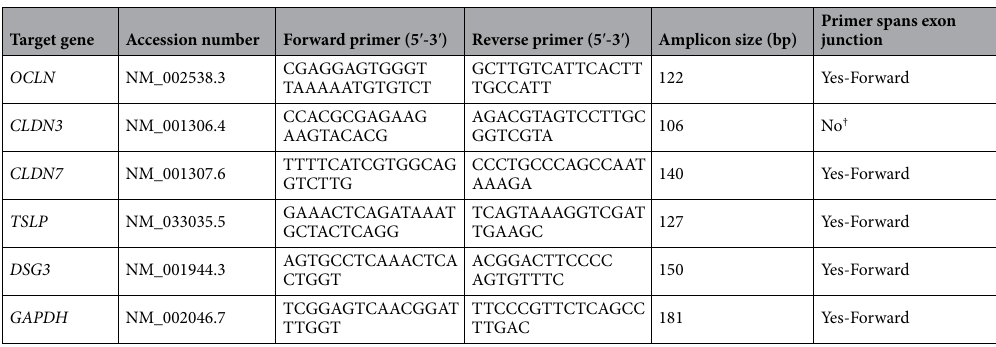
Table 6. List of primers used for SYBR Green qPCR. † CLDN3 has only one exon, thus the primer was designed within the